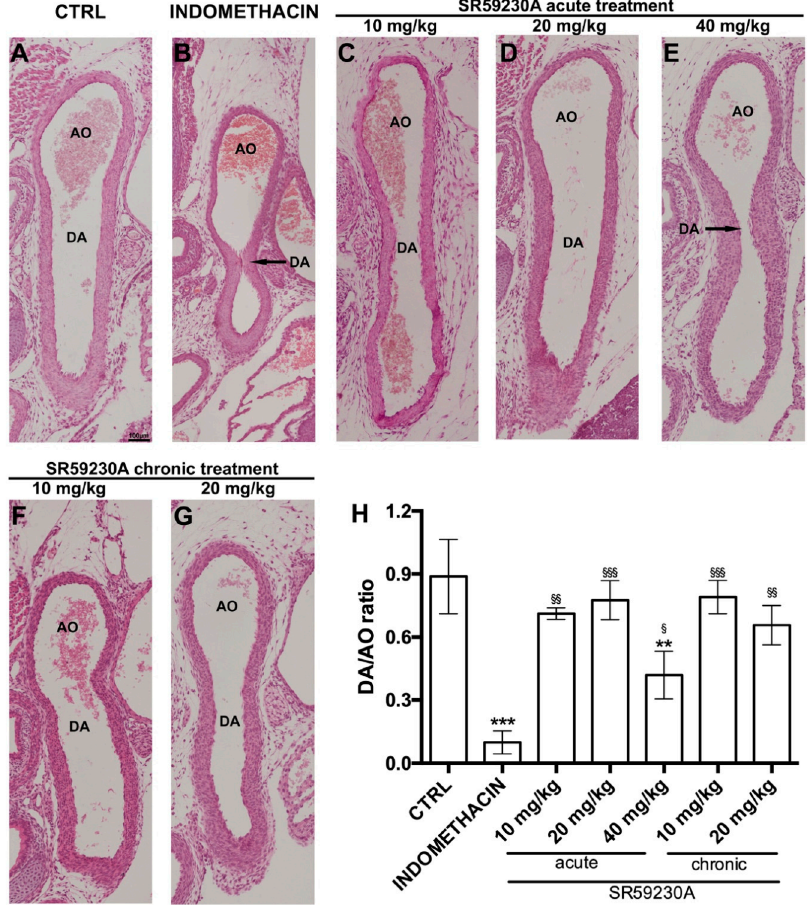
Figure 5. Morphometrical analysis of the ductus arteriosus (DA) patency. Representatives pictures of H&E-stained DA histological sections (panels A – G ) and morphometrical analysis of mean DA diameter, expressed a DA / AO ratio (panel H ) from fetuses of each experimental group. Compared with the untreated animals (CTRL), acute administration of 40 mg / kg SR59230A or 20 mg / kg indomethacin caused significant reduction of DA patency. AO = descending Aorta. Scale bars are indicated in each panel. At least 20 fetuses of 5 litters were evaluated for each experimental group. Values are means ± S.E.M. and are representative of five independent experiments. (one-way anova test), § p < 0.05, §§ p < 0.01 and §§§ p < 0.001 versus indomethacin; ** p < 0.01 and *** p < 0.001 versus